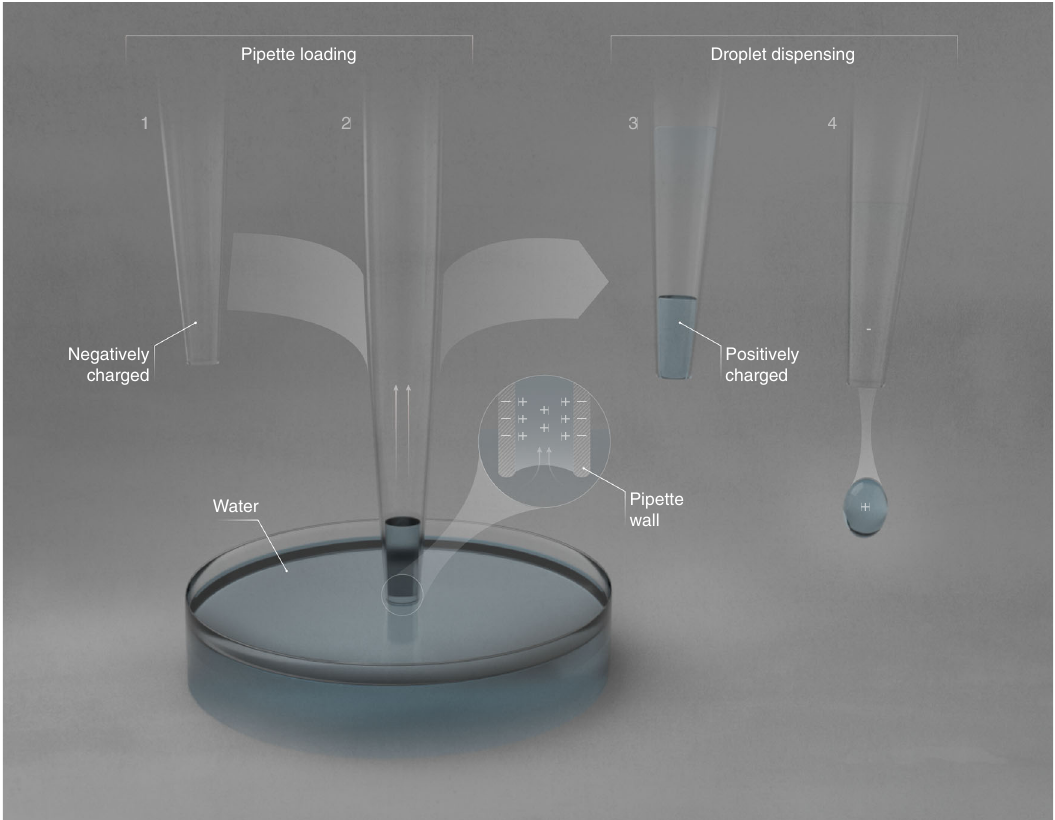
Fig. 6 Proposed mechanism for the electri fi cation at water-hydrophobe interfaces. (1) Hydrophobic surfaces such as polypropylene, FDTS, and PTFE are intrinsically negatively charged. (2) When a hydrophobic capillary draws water in from an electrically neutral water reservoir, it selectively attracts cations that populate the electrical double layer (shown in the inset). (3) When the capillary is pulled out of the water reservoir, it carries water with a net-positive charge, for instance comprising H 3 O + and other cations present, leaving behind an equal and opposite charge in the water reservoir. (4) When the water is dispensed from hydrophobic pipettes, hydrophobicity ensures that the entire volume exits the capillary, i.e., leaving no thin layer of water behind. Thus, the formed pendant droplet contains the excess positive charge that was drawn in originally, and it experiences repulsion from a positively charged plate as observed in our experiments (Fig.